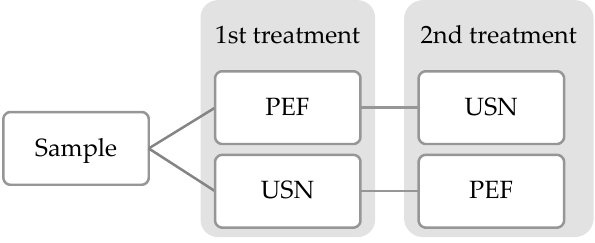
Figure 1. Scheme of the different experimental treatments conducted. PEF: Pulsed Electric Fields, USN: Ultrasounds.